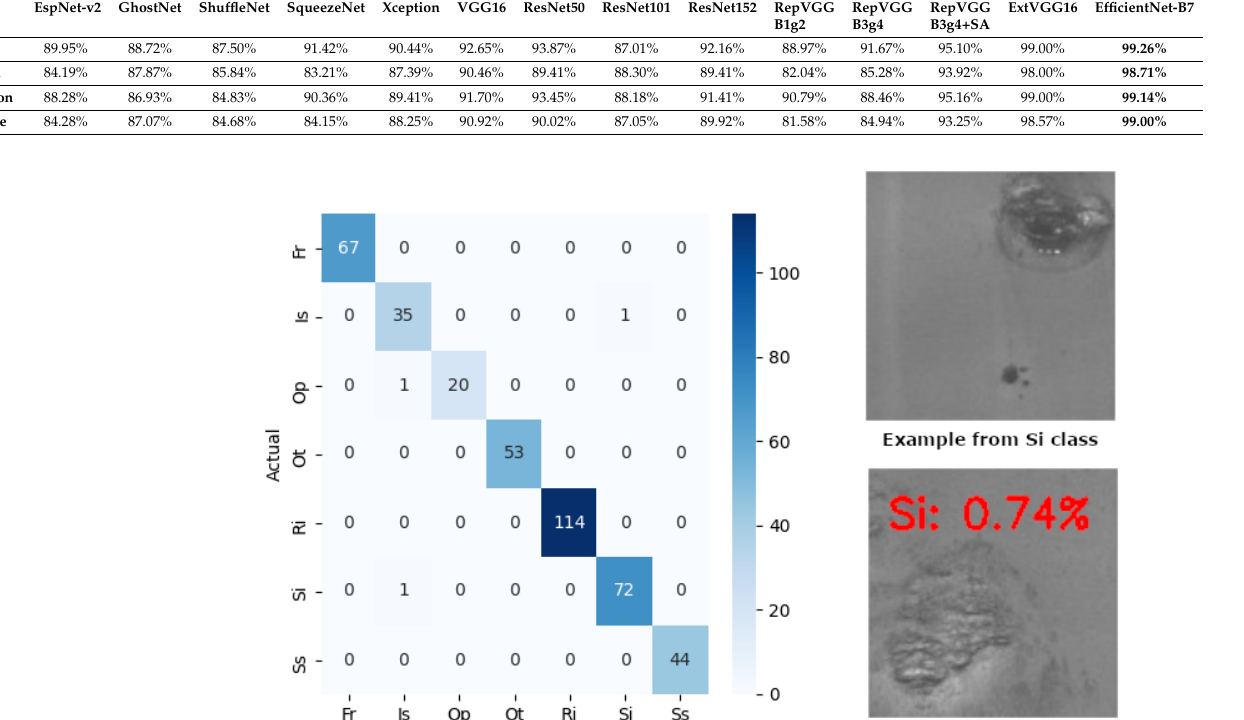
Table 3. Comparison of EfficientNet-B7 with other models on X-SSD (all data are based on ref. [1] except for ExtVGG16 [10] and EfficientNet-B7). Best values are highlighted in bold.